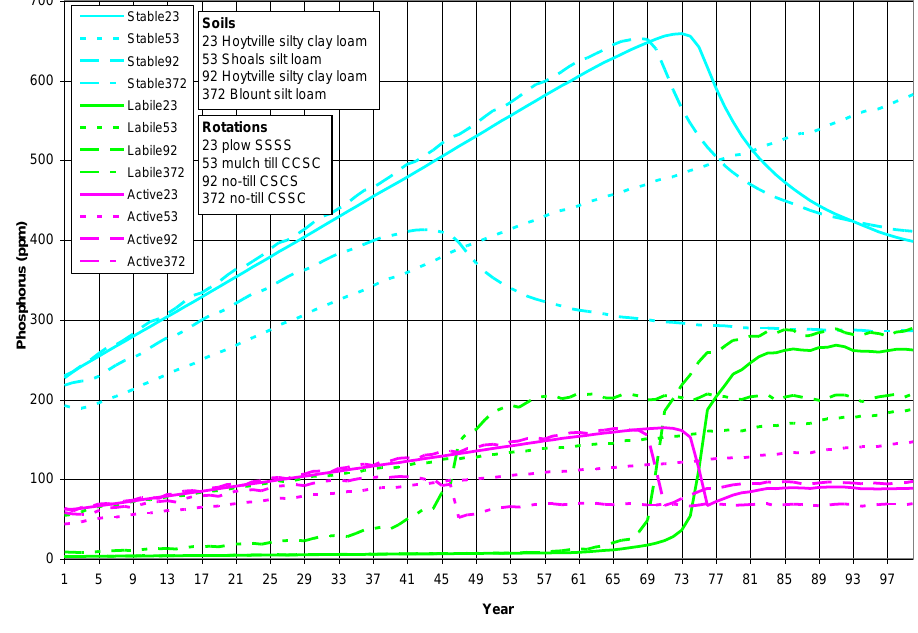
Figure 8 . In situ stable, active and labile (inorganic) soil P top 200-mm of soil for four